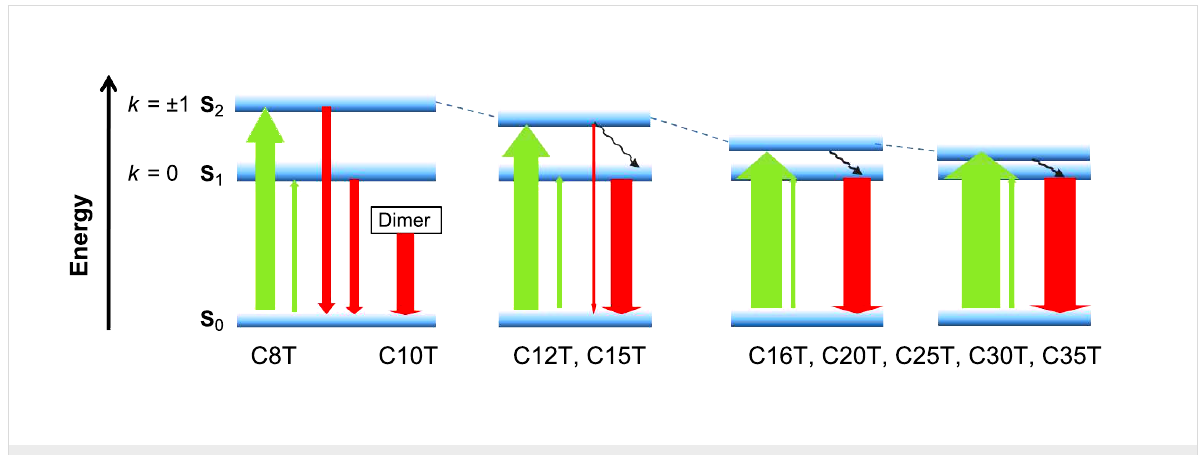
Figure 3: Sketch of the electronic transitions in the macrocycles: Ground state (S 0 ), first (S 1 ) and second (S 2 ) excited state. Plain arrows are weighted by the transition probability. The black wavy arrows represent nonradiative deactivation.